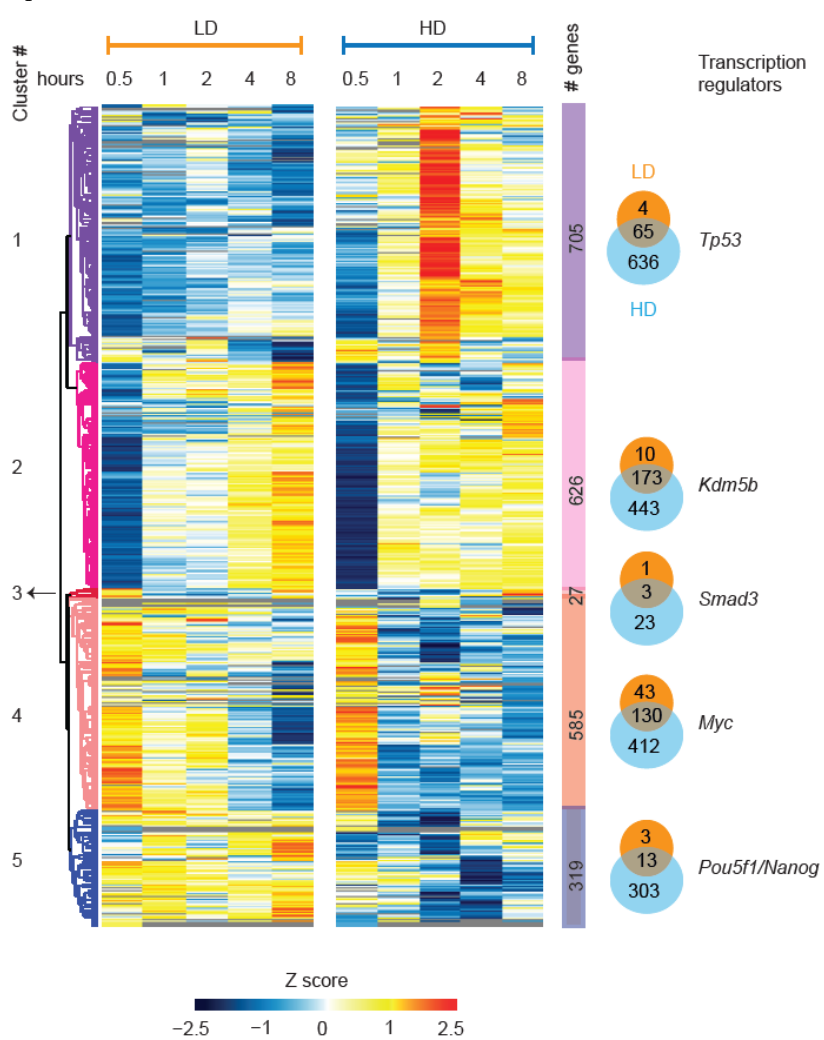
Figure 7. IR dose-dependent nascent transcriptome dynamics. Heatmap of hierarchically clustered z-scored log2 ratios of IR-responsive nascent transcripts (NTs). The left and right panels represent NT dynamics from 0.5 h until 8 h after LD and HD, respectively. Clusters are labeled on the left side, and the number of genes represented by each cluster is indicated on the right side inside color-coded bars. Overlap of genes between LD and HD per cluster is indicated in a Venn diagram plot, where orange and blue circles represent LD- and HD-responsive genes, respectively. The top transcription regulator enriched for each cluster using Enrichr is indicated next to the Venn